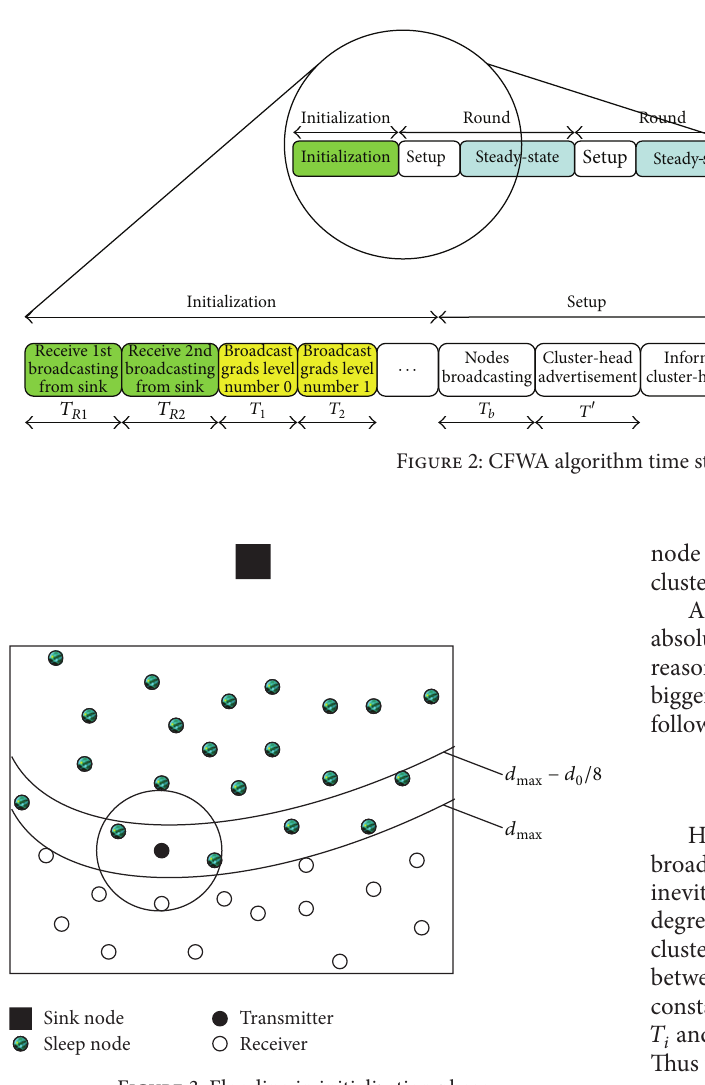
Figure 3: Flooding in initialization